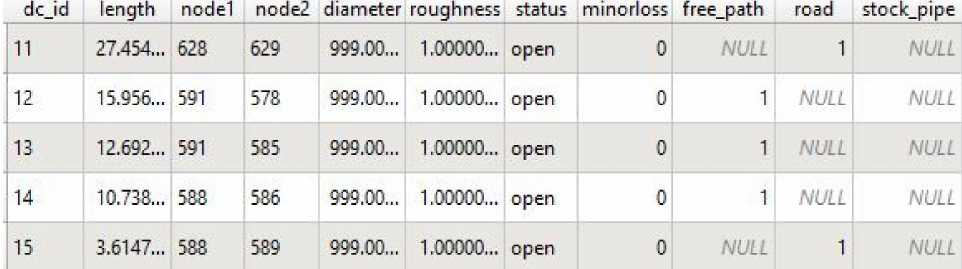
Figure 3. Detail of an attribute table of possible routes: Route-specific properties in the columns “free_path”, “road”, and “stock_pipe”, which are taken into account in the subsequent topology optimization, can be